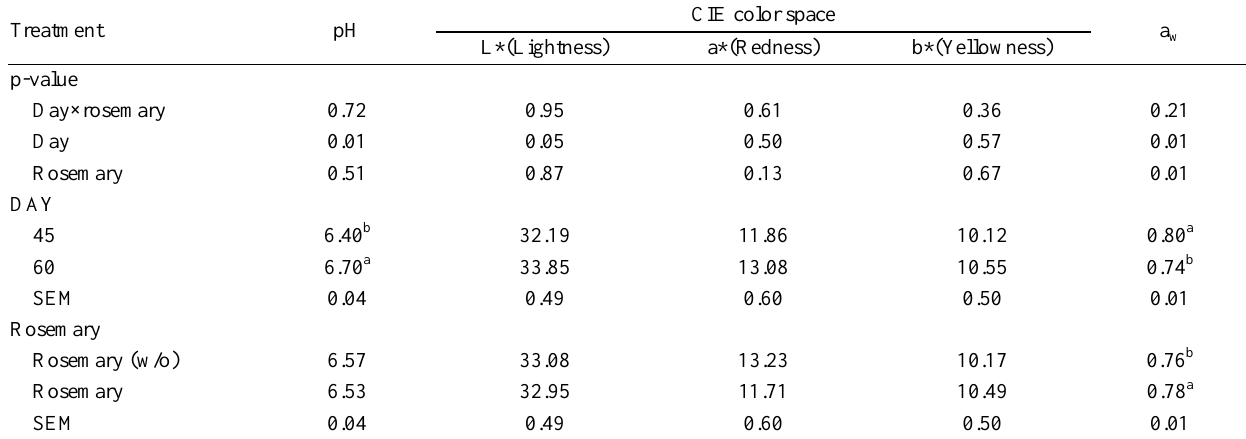
Table 2. pH, color and water activity of salchichon modified sausage after 45 or 60 d ripening and/or added rosemary powder Treatment